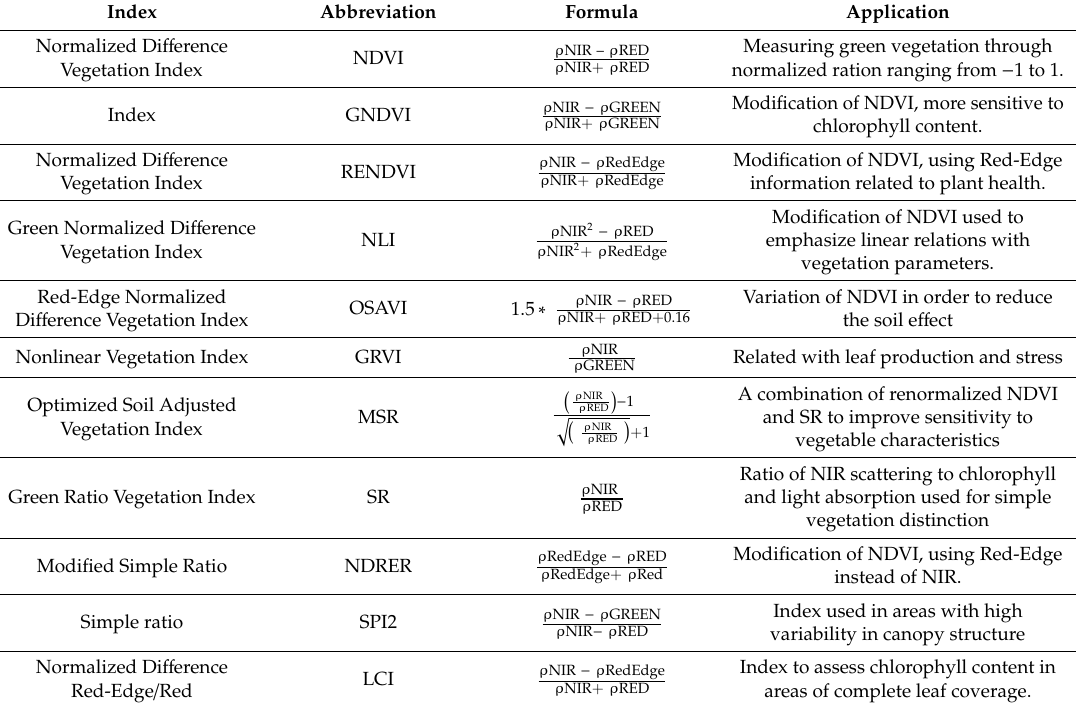
Table 2. Vegetation Indices (VIs) used to create spectral profiles of the tomato plants from the multispectral data with formulae and traditional applications (obtained from